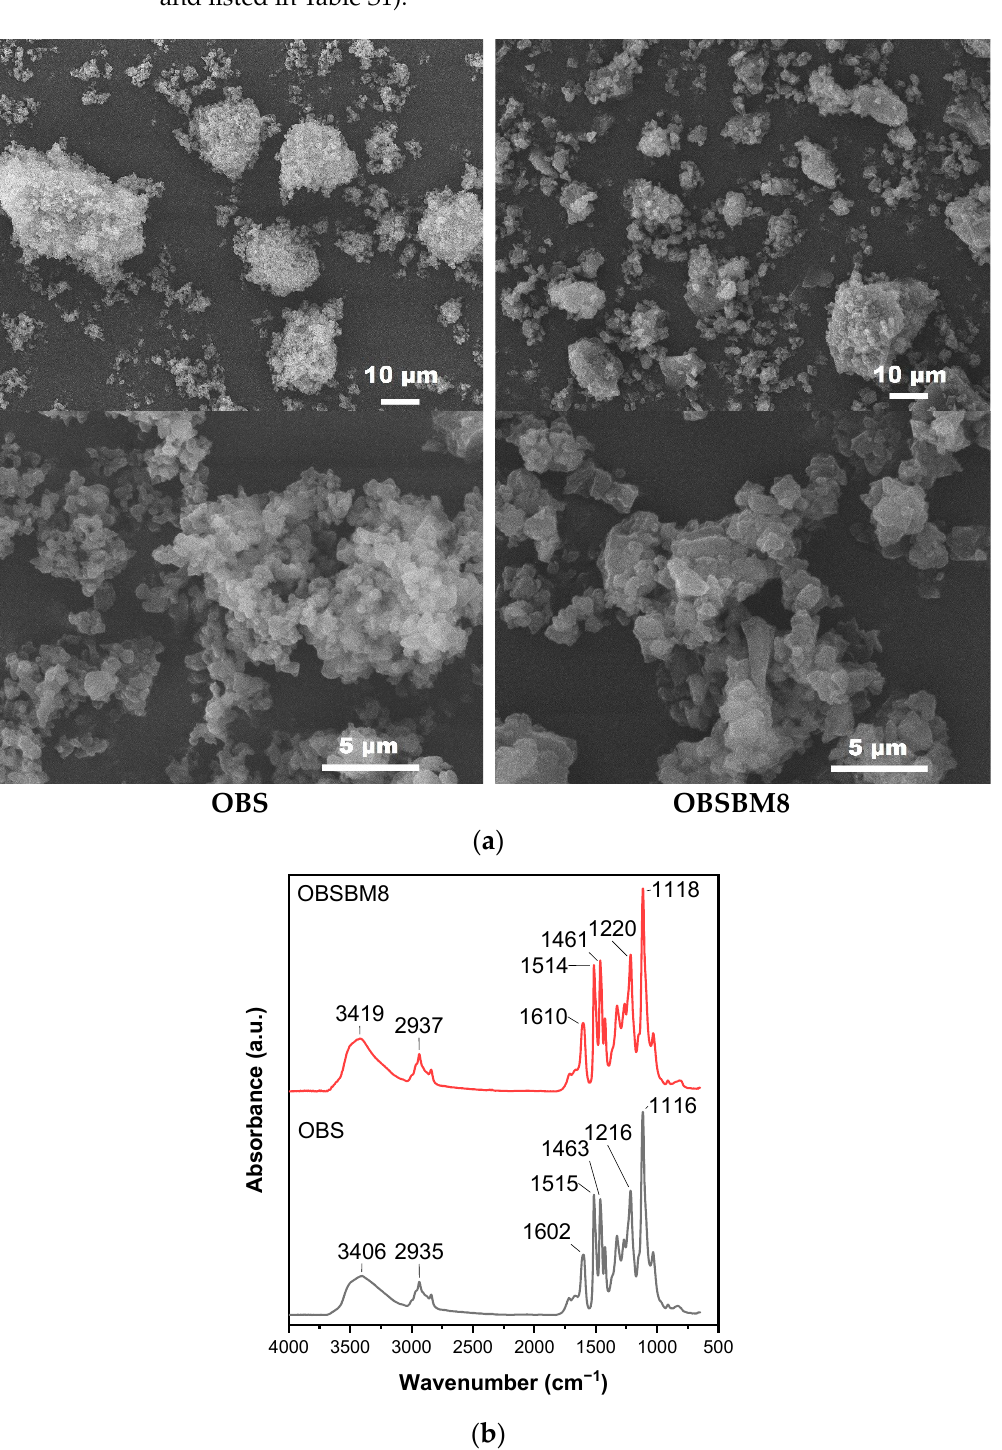
Figure 1. Characterization of lignin ( a ) SEM images, ( b ) FTIR spectra.